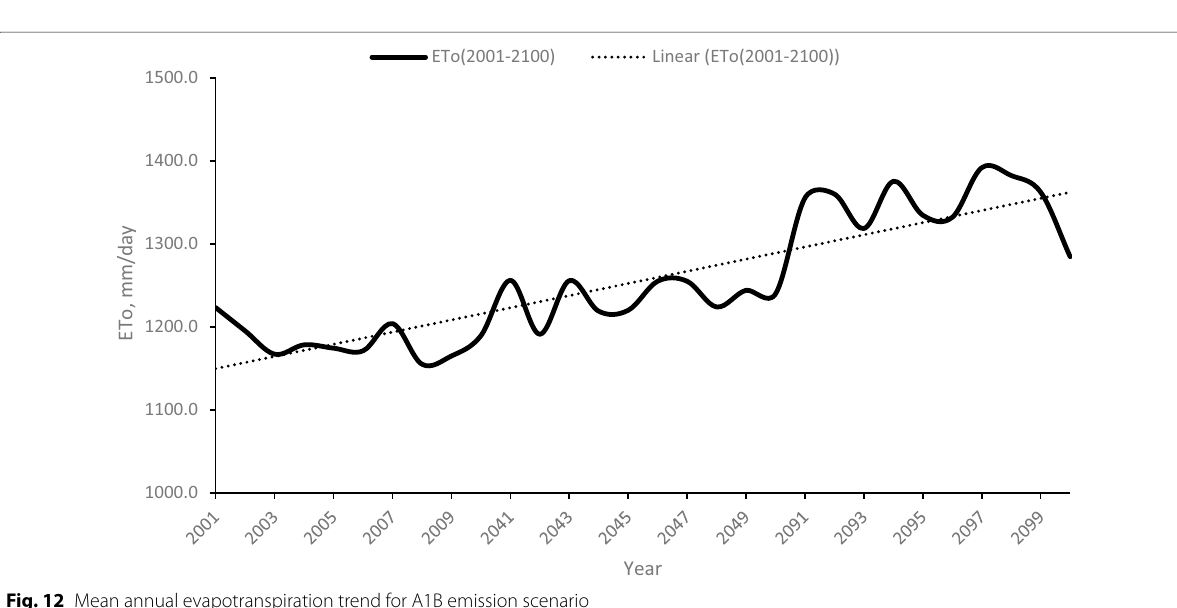
Fig. 12 Mean annual evapotranspiration trend for A1B emission